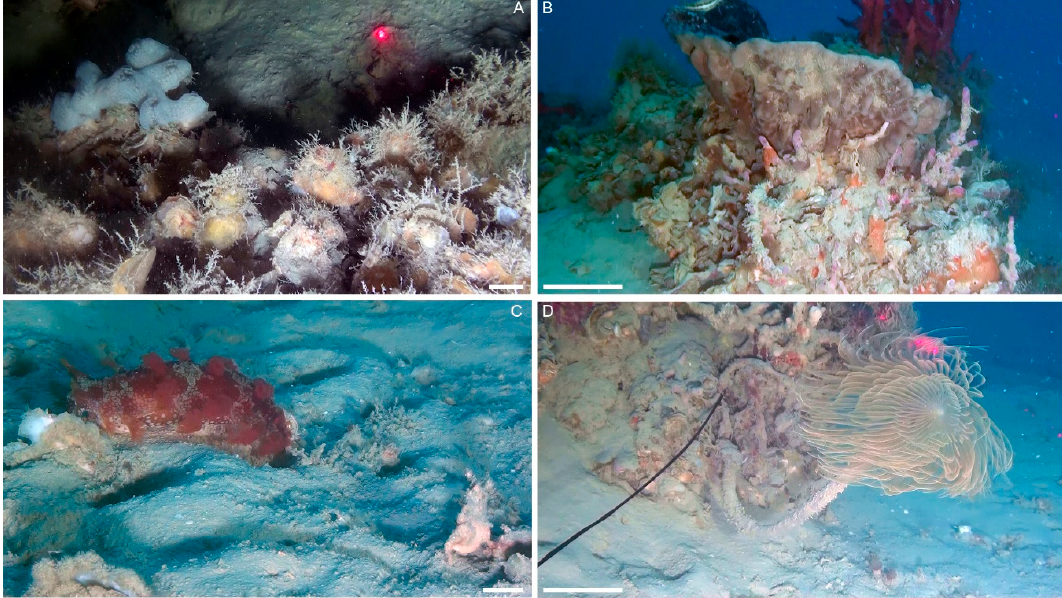
Figure 5. Examples of biodiversity of Neopycnodonte cochlear reefs. ( A ) The colonial tunicate cf. Diplosoma spongiforme on top of small N. cochlear bed, surrounded by a hydrozoan turf at 70 m (Vieste); bar = 3 cm. ( B ) Spongia lamella , Axinella polypoides and Ulosa stuposa are common findings at ca 60 m (Vieste) on Neopycnodonte reef; bar = 10 cm. ( C ) Marionia blainvillea (family Tritoniidae) grazing on muddy sediment around the N. cochlear reef at 50 m (Vieste); bar = 1 cm. ( D ) Sabella spallanzanii growing at the base of a m-thick Neopycnodonte reef at 60 m (Vieste); bar = 5 cm. Table 1. Site locations metadata.